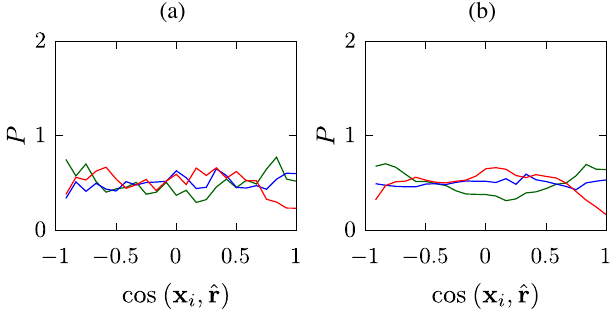
FIG. 11. PDF of the cosine of the angle between the lab coordinates x i and the fiber orientation unit vector ˆ r ¼ r = j r j for the whole observation volume (a) and conditioned on the region in the vicinity of the impellers ( x= L < 0 . 71 ) (b). The axis x 3 points toward the main camera direction, while x 1 and x 2 are orthogonal to it. The fiber length is c= L ¼ 0 . 76 and the turbulence is generated by rough wheels rotating at 400 rpm.